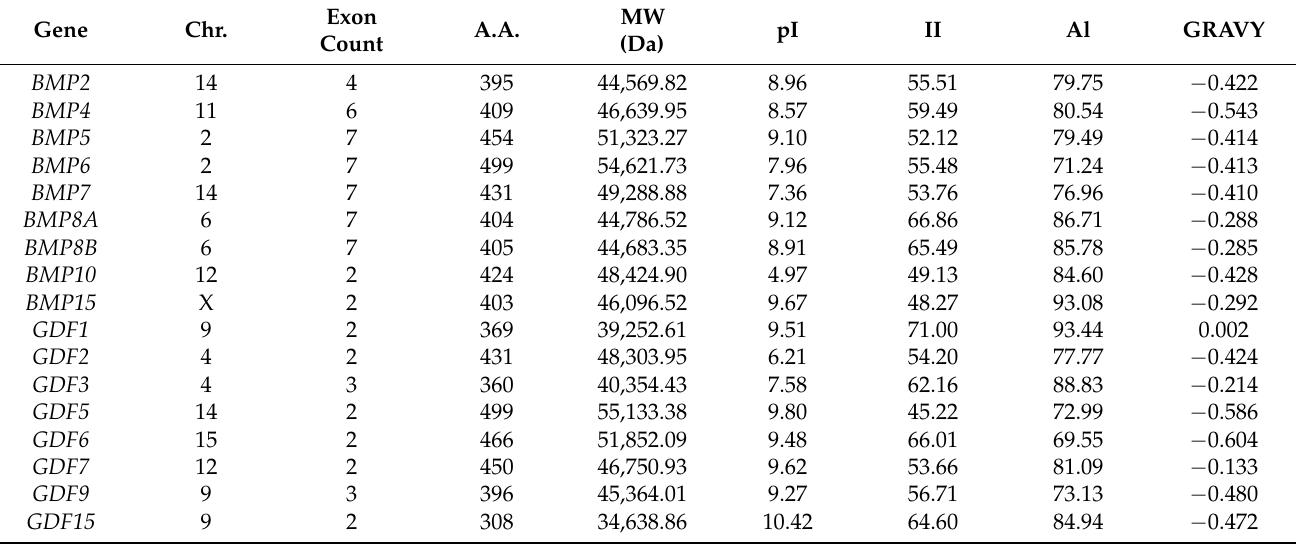
Table 3. Physicochemical properties of the BMP-like genes of the buffalo TGF- β gene family.